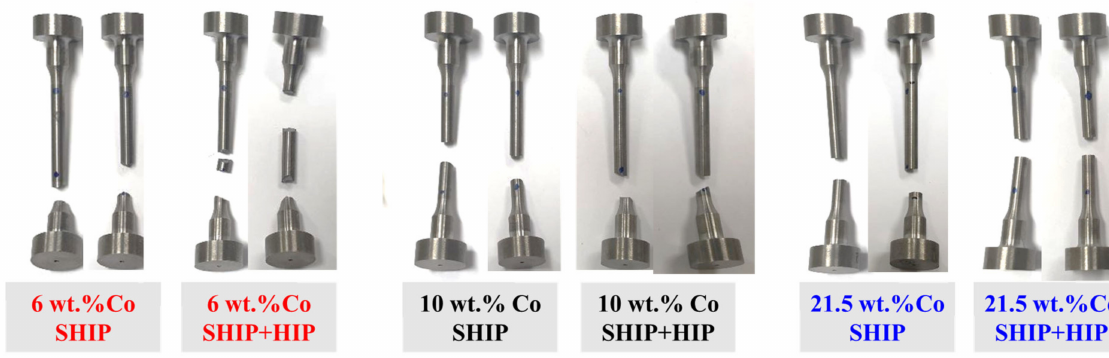
Figure 8. View of the tensile specimen using the proposed jig.